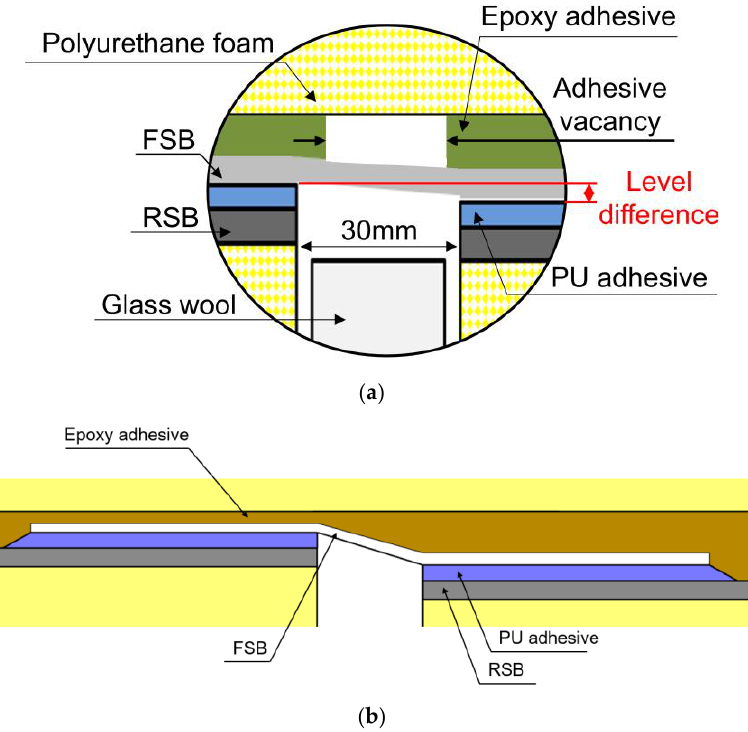
Figure 2. Schematic composition of ( a ) a secondary barrier in Mark III–type LNG insulation systems and ( b ) variation of the mechanical characteristics caused by the level difference phenomenon.